Question: Does the figure show an increasing or a decreasing trend?
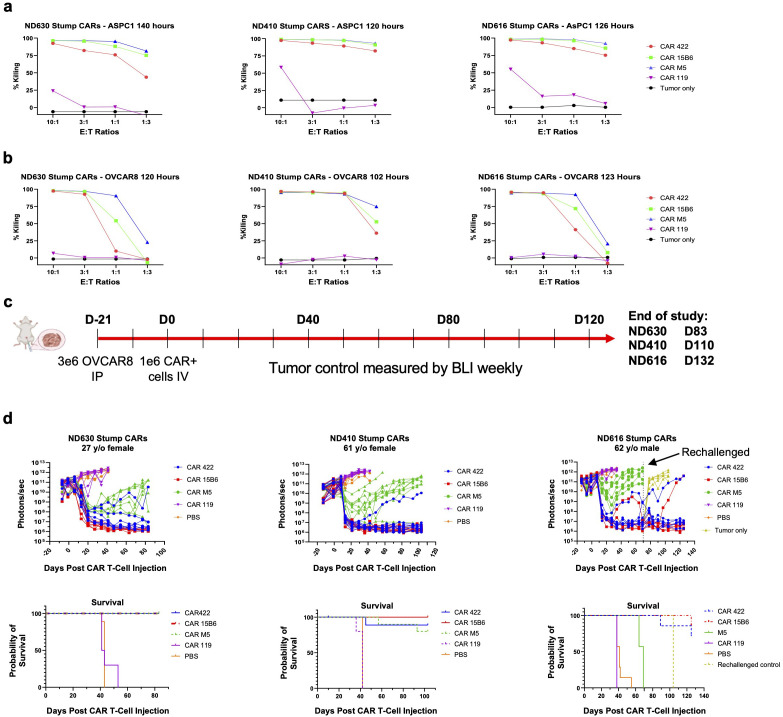
Answer: increasing